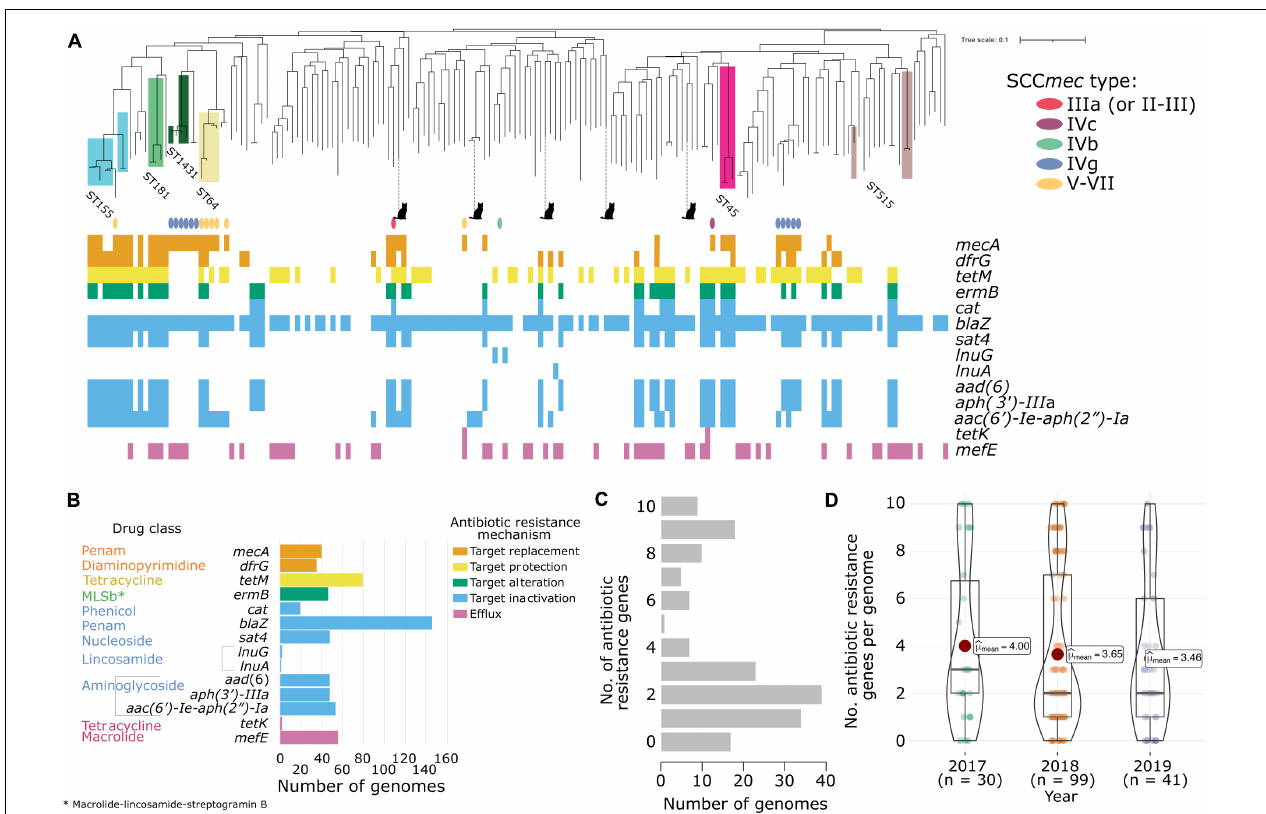
FIGURE 1 | Antibiotic resistance characteristics of the 170 New England S. pseudintermedius population. (A) Gene presence–absence matrix showing the distribution of antimicrobial resistance genes present in each genome (colored blocks—present; white—absent). The midpoint-rooted maximum likelihood tree was built using sequence variation in 2,013 core genes. Scale bar represents the number of nucleotide substitutions per site. Also shown are the SCC mec types identified using staphopia-sccmec. For visual clarity, only STs represented by 3 or more genomes were labeled. ST information of other genomes in the tree are listed in Supplementary Table 1 . Isolates from cats were depicted with a cat icon, while the rest came from dogs. (B) Bar plots showing the number of genomes that carry resistance genes in each drug class. The bars and gene names are colored according to the resistance mechanism defined by the CARD database. (C) Distribution of the number of acquired resistance genes per genome (D) Violin plots showing the number of resistance genes per genome per year of sampling. Associated box plots depict the minimum, first quartile, median, third quartile and maximum values, with data points